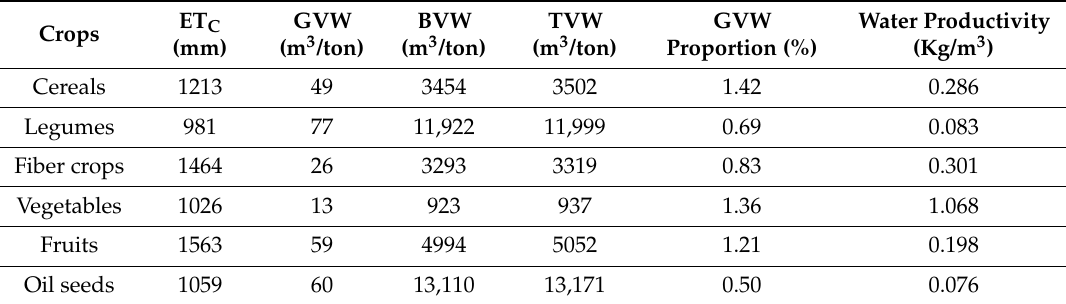
Table 3. 10-year mean of virtual water content and other components in the entire province (ET C :